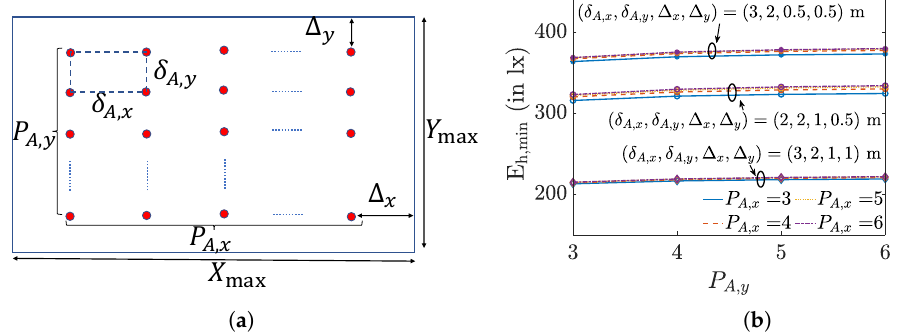
Figure 5. ( a ) Receiver area layout of size X max × Y max with P A , x × P A , y arrays and ( b ) E h,min for different P A , x , P A , y , δ A , x , δ A , y , ∆ x and ∆ y